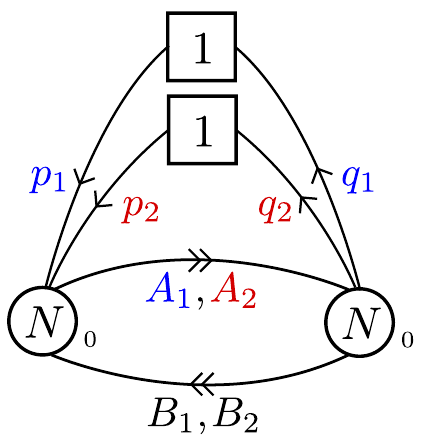
Figure 5 . Quiver diagram for the worldvolume theory of N M2-branes probing the cone over Q 1 , 1 , 1 . Coloured fields are present in extra superpotential terms, here ∆ W = p 1 A 1 q 1 + p 2 A 2 q 2